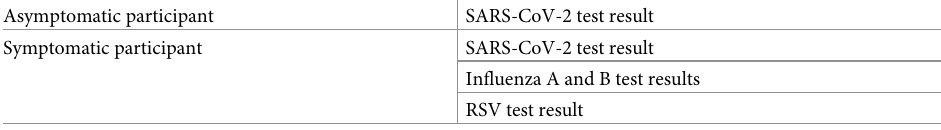
Table 2. Data collected weekly from asymptomatic and symptomatic participants who are tested. Asymptomatic